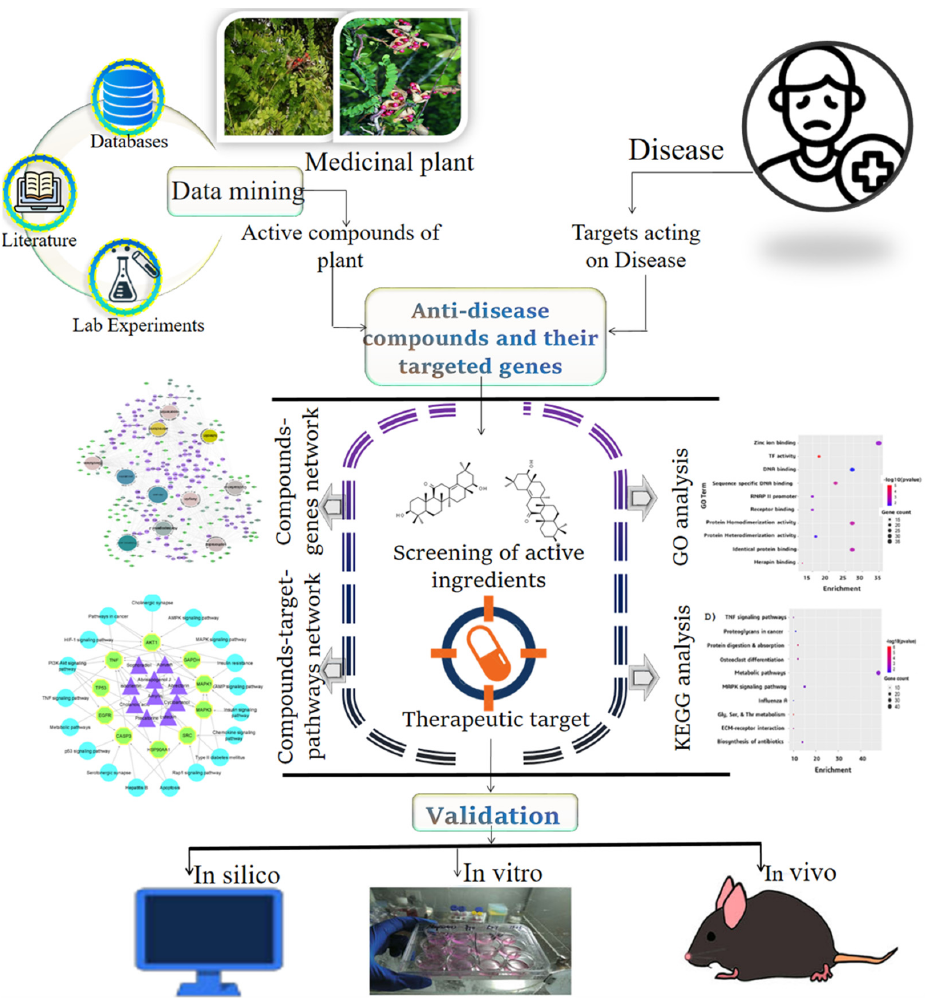
Figure 2. Graphical synopsis of network pharmacology research for the discovery of herbal medicines-derived targets, effect prediction, mechanism clarification, and new drug assistant discovery using network pharmacology approach. It analyzes the information from public data, high-throughput experimental data, and herbal medicinal data and constructs network using technologies of network expansion, optimization, comparison, knockout, and addition. Finally, it carries out computational and experimental verifications.